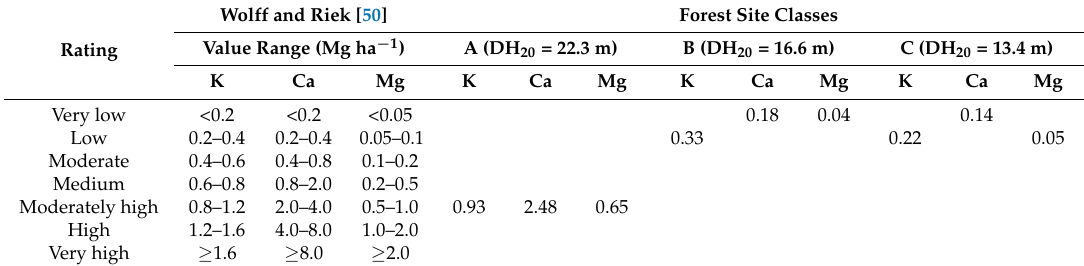
Table 9. Short and medium term available nutrient stocks (organic soil layer + mineral soil standardized